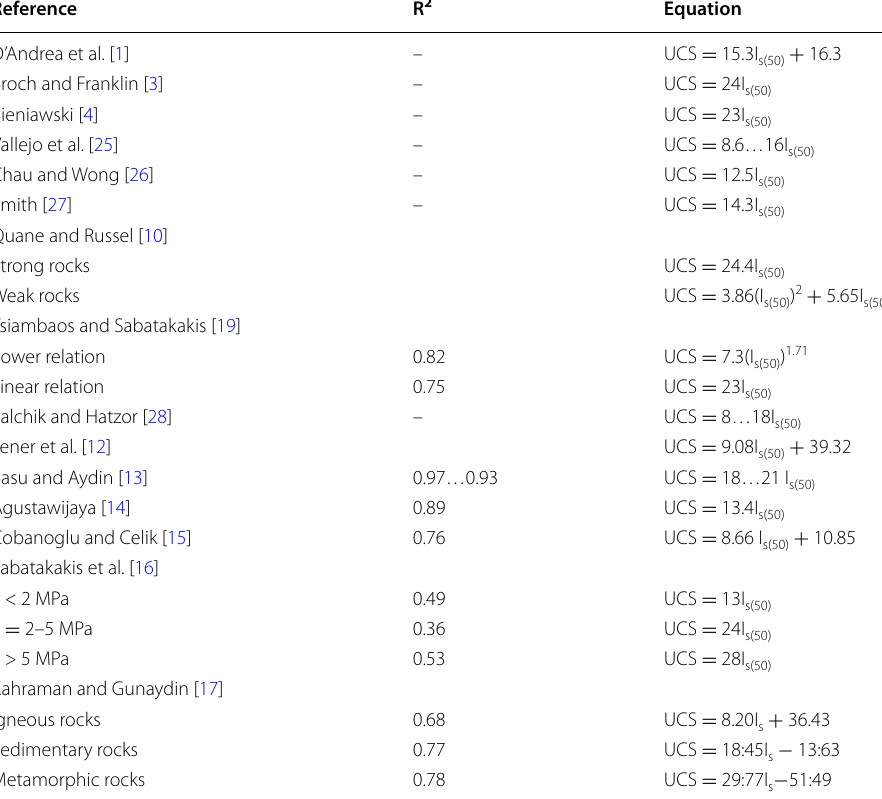
Table 1 Equations correlating the UCS to the point load index Reference R 2